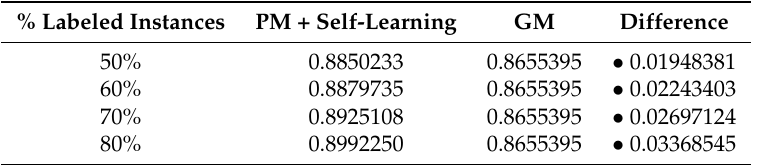
Table 9. D4: Smartphone dataset accuracies for varying % of labeled instances with self-learning (PM + self-learning) and the General Model